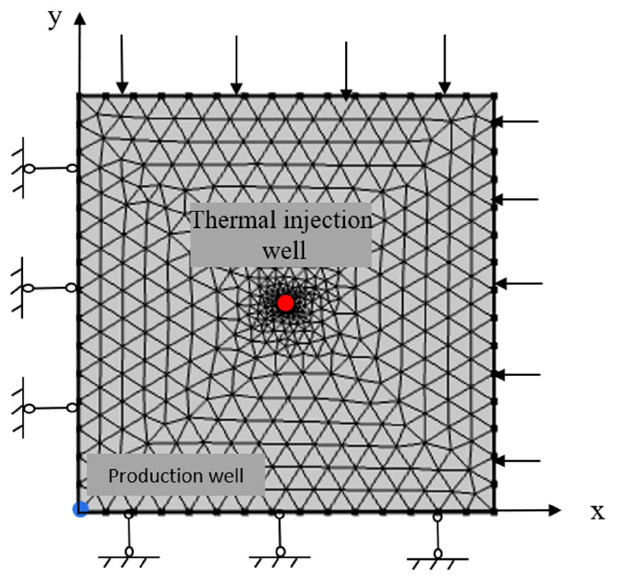
Figure 11. Computation model of shale gas heat injection